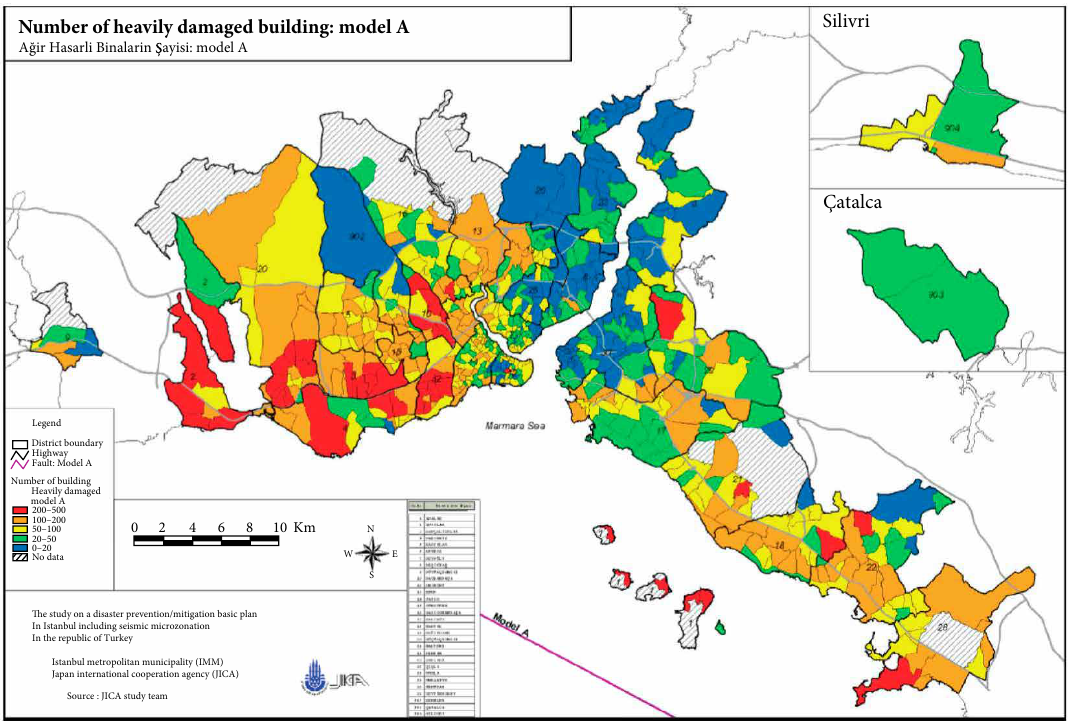
Figure 1: Number of heavily damaged buildings in model A [1].